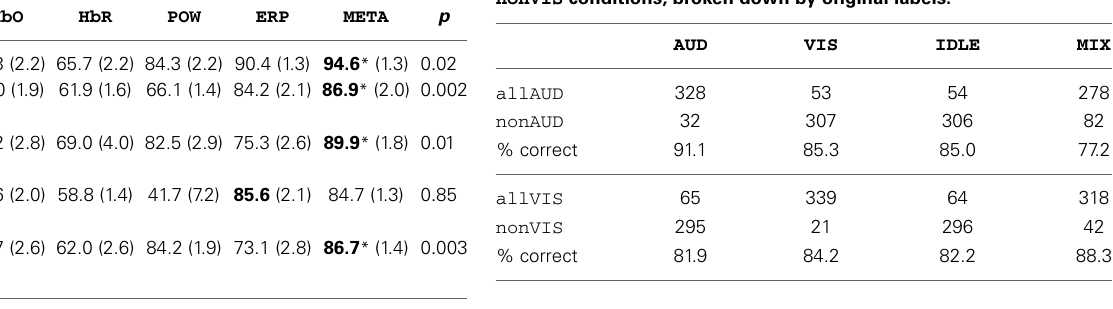
Table 5 | Subject independent correct classification rate (in %) and confusion matrix for the allAUD vs. nonAUD and the allVIS vs. nonVIS conditions, broken down by original